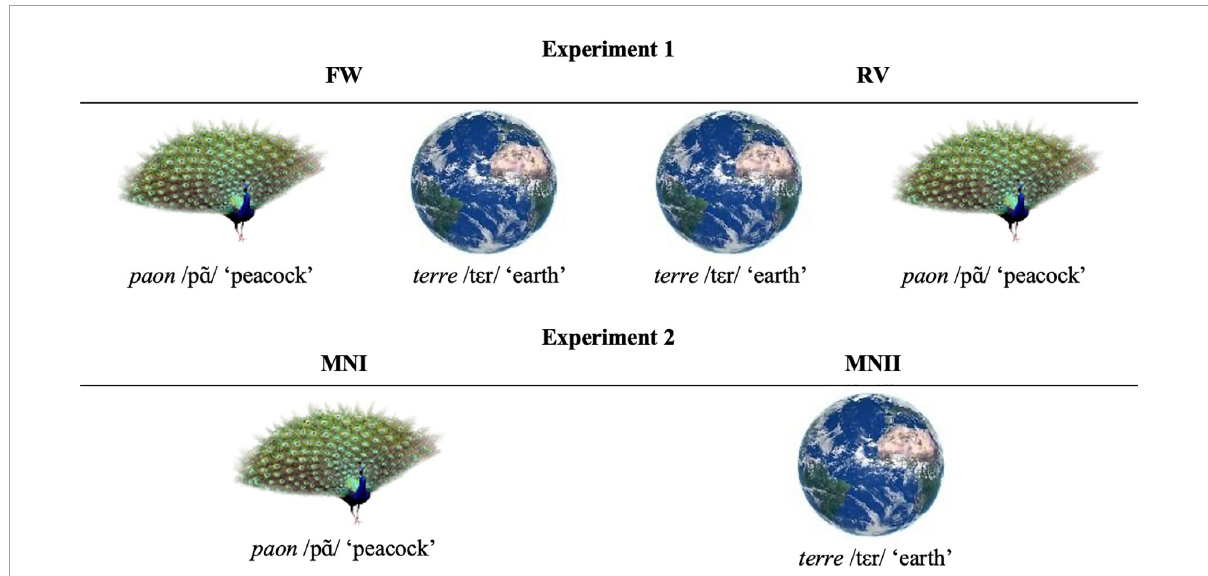
FIGURE3 Variations for an experimental stimulus: félin — paon terre ; composed by the images of paon /pã/ “peacock” and of terre /t ε r/ “earth” giving the French rebus panthère /pãt ε r/ “panther” and the target word associated to panthère: félin /fel ε (reverse) variations of Experiment 1 and in the MNI and MNII variations of Experiment 2.